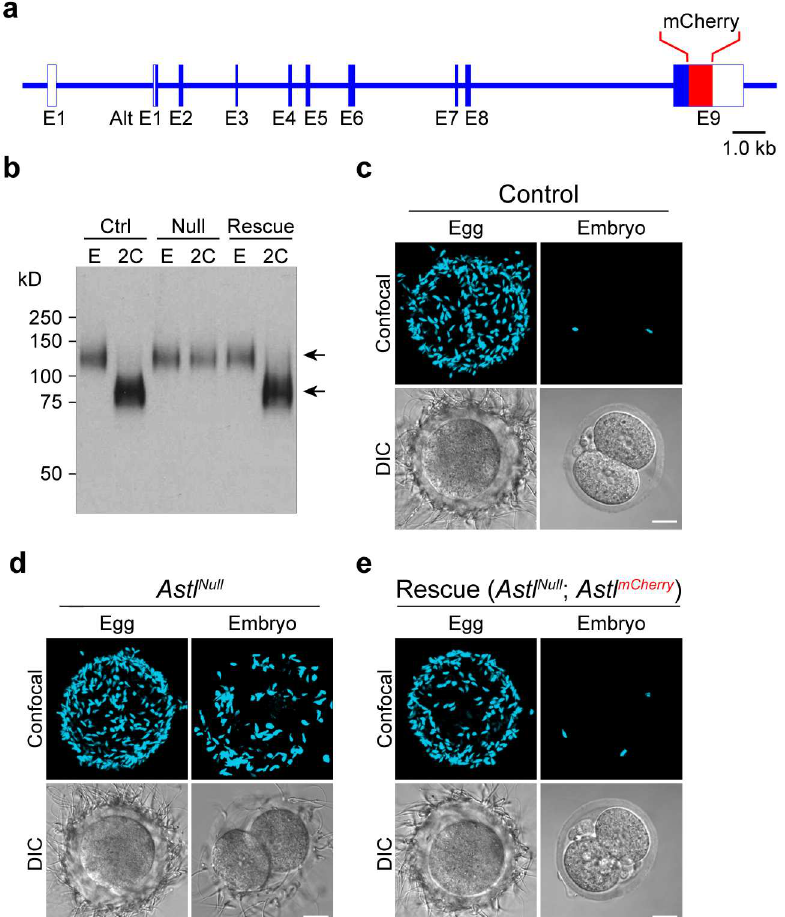
Fig 1. Astl mCherry rescuesthe Astl Null phenotype. (a) Schematic of the Astl mCherry transgene. (b) Immunoblot of eggs (E) and 2-cell embryos (2C) from wild-type(Ctrl), Astl Null (Null) and Astl Null ; Astl mCherry (Rescue) mice (10–15eggs or embryos per lane). Primary antibody (M2c.2) binds to the C-terminus of ZP2 and detected intact (upper arrow) and cleaved(lower arrow) protein. Molecularmass (kD) on left. (c-e) Mouse sperm bindingto eggs and two-cell embryos from: (c) , wild-type; (d) , Astl Null ; and (e) , Astl mCherry rescue mice. Confocal projections (upper)and DIC (lower) images were obtainedafter fixation and staining with Hoechst. Scale bar, 20 μ